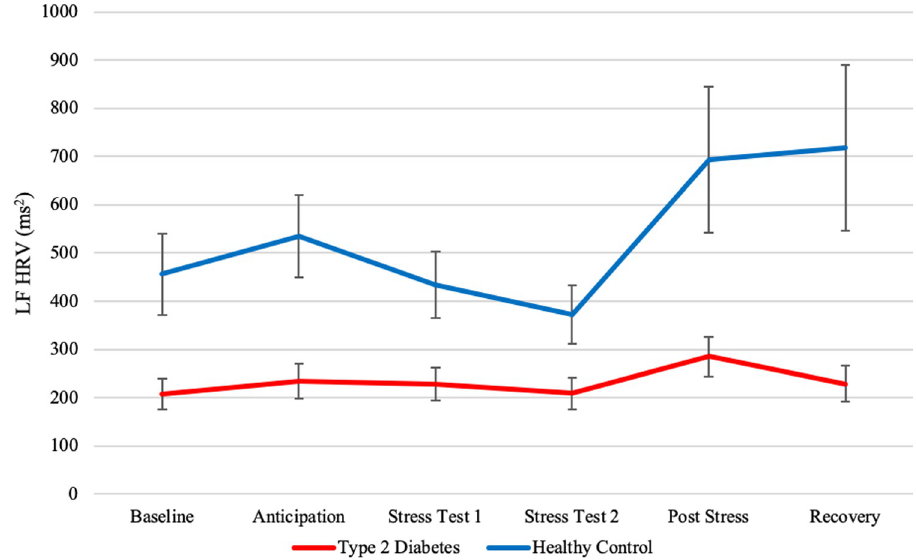
Fig 3. Mean LF HRV and standard errors of type 2 diabetes patients and healthy controls before, during and after stress induction. Note: Values depict averages of 3-minute HRV-samples. Time from baseline to anticipation was on average 27 minutes. The stress test took on average 14 minutes. Time from post-stress to recovery was approximately 15 minutes.